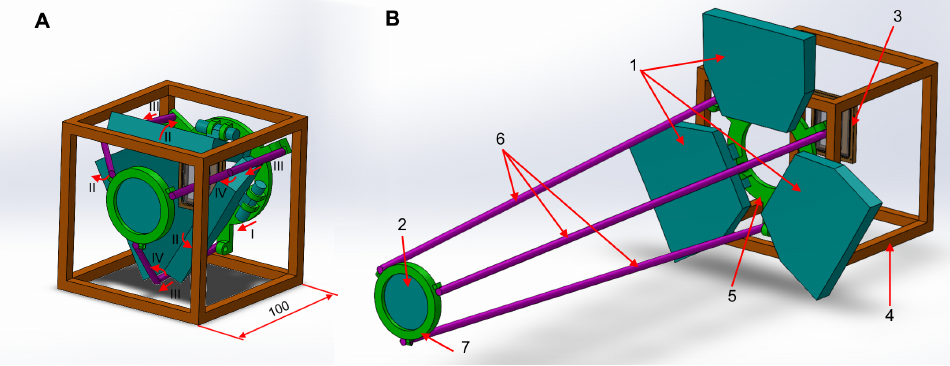
Figure 4. Opto-mechanical concept of the deplorable telescope fitting in a 1U CubeSat: ( A ) stowed position; ( B ) fully deployed